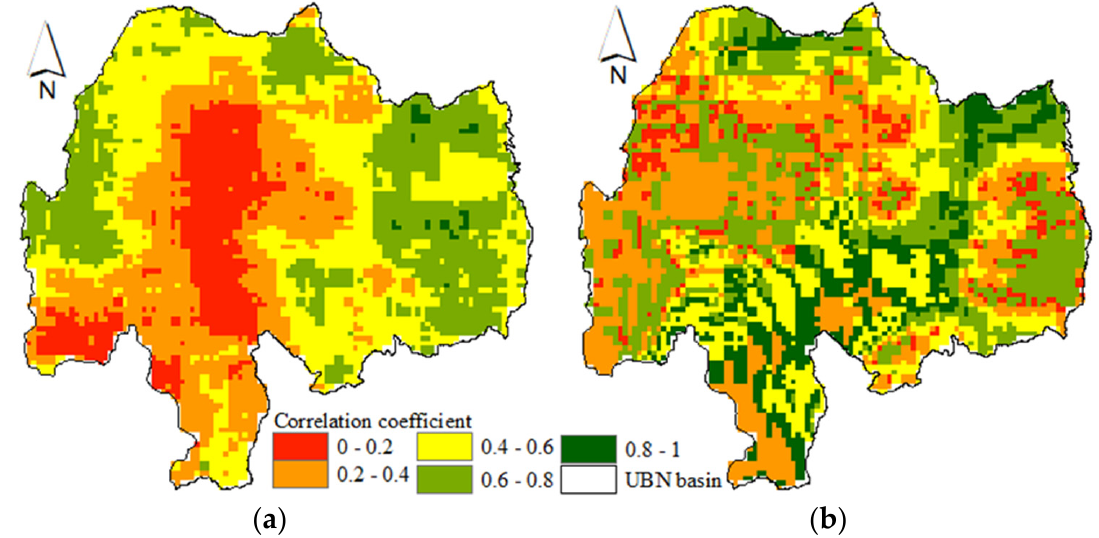
Figure 4. The spatial Pearson correlation coefficient values generated using the time series meteorological (SPI) and agricultural (SMDI) drought indices for Kiremt season ( a ) and annual ( b ) time scales.